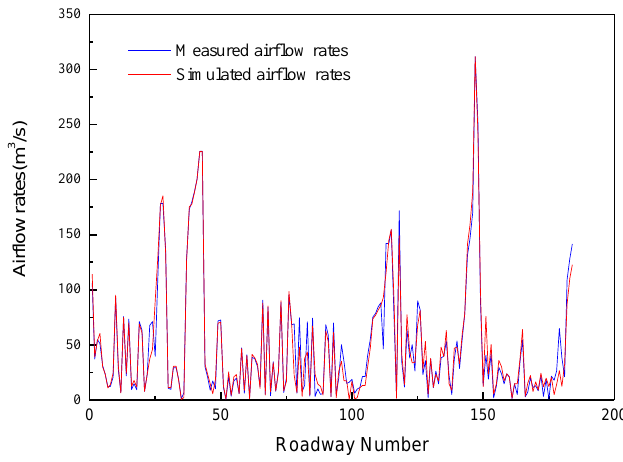
Figure 3. Comparison of simulated airflow rate and measured data.